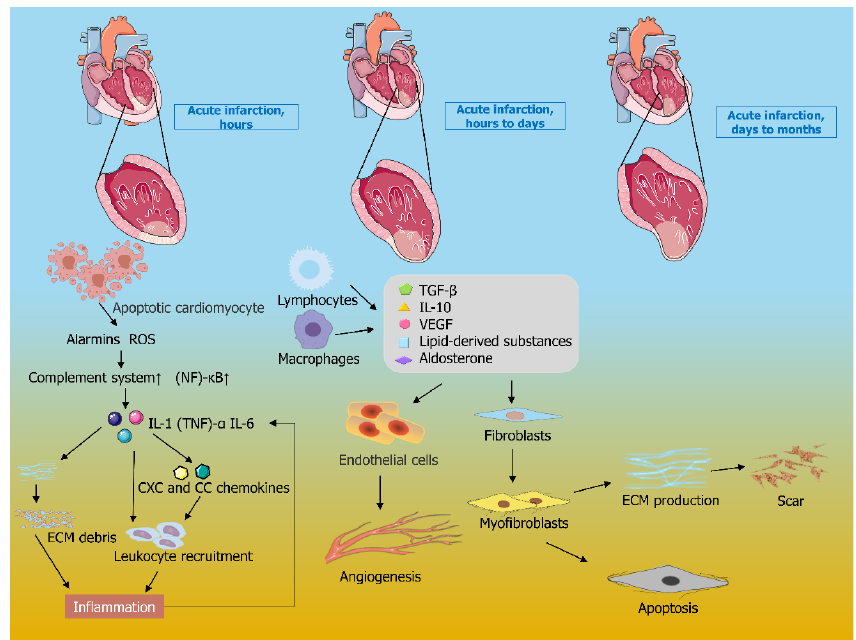
Figure 2. Biological progression after myocardial